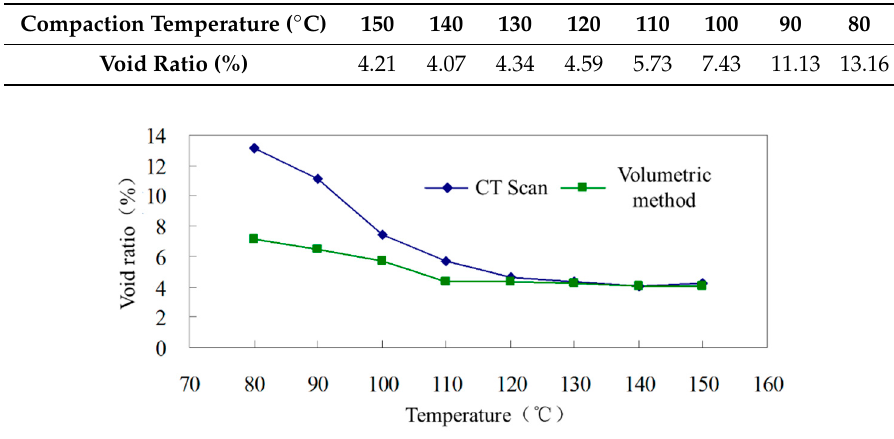
Table 8. Void ratio of zeolite asphalt mixture (%).